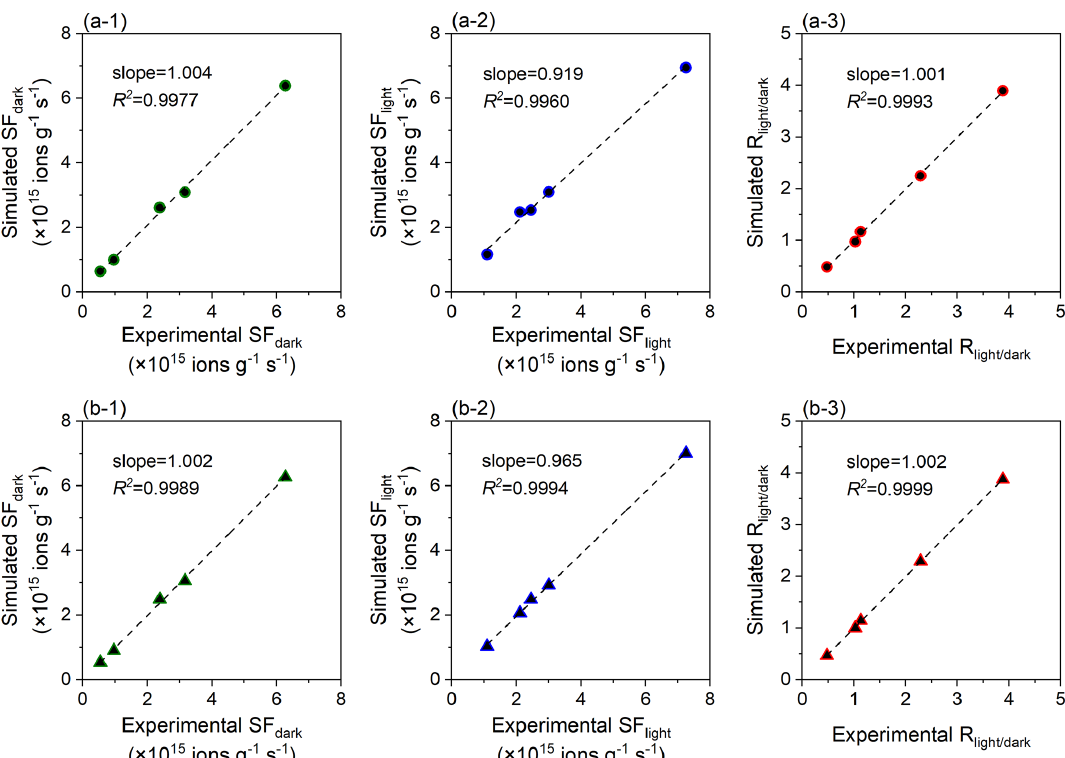
Figure 3. Regression analysis of the sulfate production rate of the dust surface. Linear relationships between the experimental SF dark , SF light , and R light / dark and those simulated by the (a) complete and (b) simplified regression models. The unit of SF (ionsg − 1 s − 1 ) indicates the amount of SO 2 − formed on the particle sample of per-unit mass per unit time, and R light / dark indicates the ratio of SF values in the presence 4 and absence of simulated solar